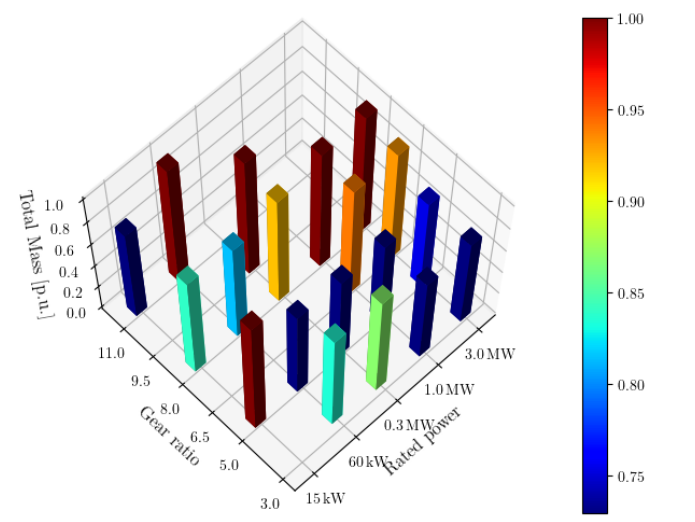
Figure 20. Total mass indications as a function of power ratings and gear ratios.